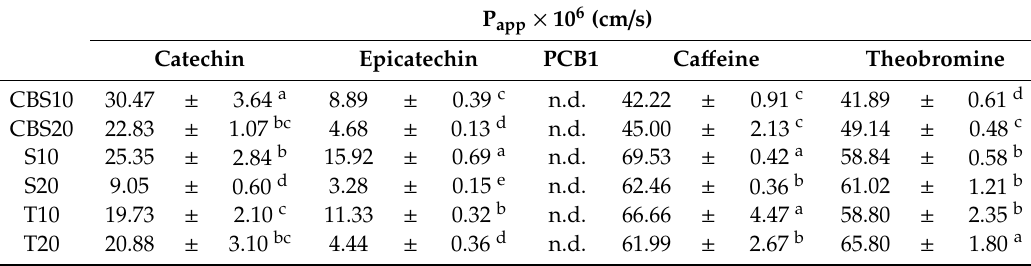
Table 1. Apparent permeability coe ffi cients (P app ) of the five target compounds found for the digested samples of CBS biscuits and CBS ingredient alone at di ff erent concentrations. Statistical comparisons were made using one-way ANOVA and Duncan’s post-hoc test at 95% confidence. P app × 10 6 (cm /